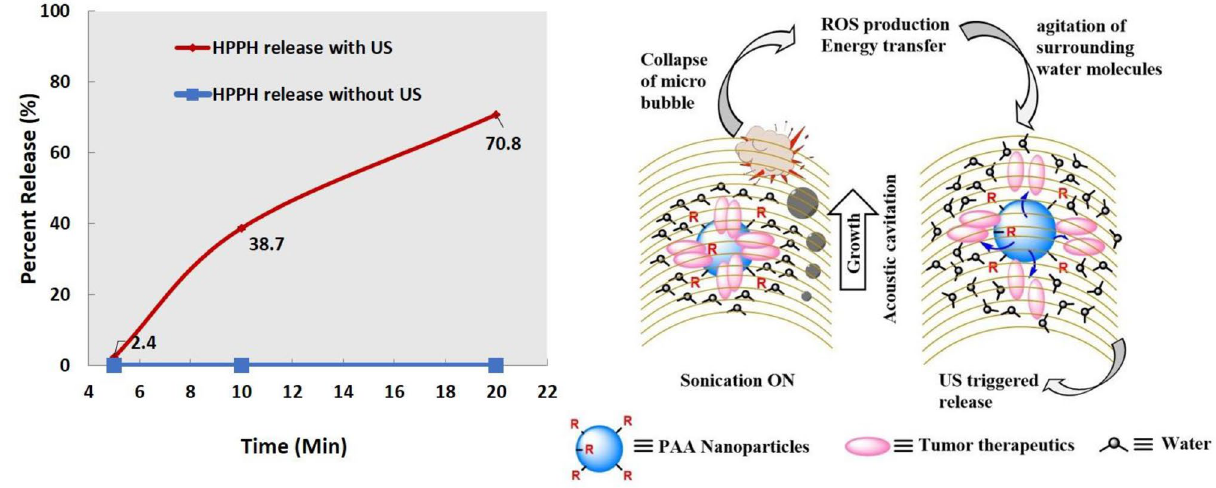
Figure 3. US-triggered release of HPPH post-loaded cationic PAA-NMe 3+ nanoparticles was determined in 1% HSA-PBS. The HPPH (ε: 47,500 L/mol/cm at 661 nm) dispersed at a concentration of 20 μM in 1% HSA-PBS solution was irradiated with US at a dose of 0.5 W/cm 2 , 3.3 MHz at 5, 10 and 20 min. At each time point, the solution was filtered through a 100 KDa centrifuge filter. The concentration of HPPH in filtrates was determined spectrophotometrically, and the release of HPPH was plotted against